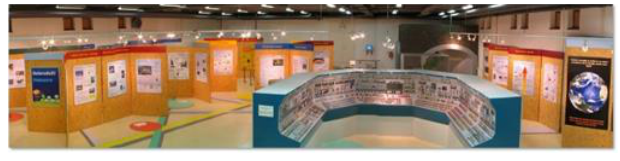
Fig. 1. Exhibition in nuclear technology information